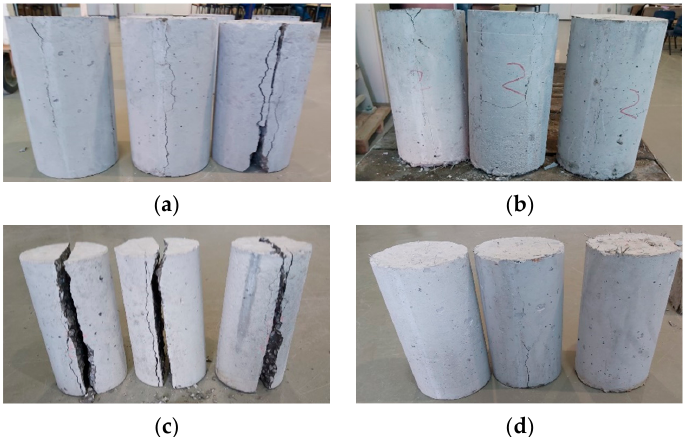
Figure 11. Failure mode of splitting tensile test specimens: ( a ) NSC-BMF0.0; ( b ) NSC-BMF0.5; ( c ) HSC-BMF0.0; ( d ) HSC-BMF0.5.